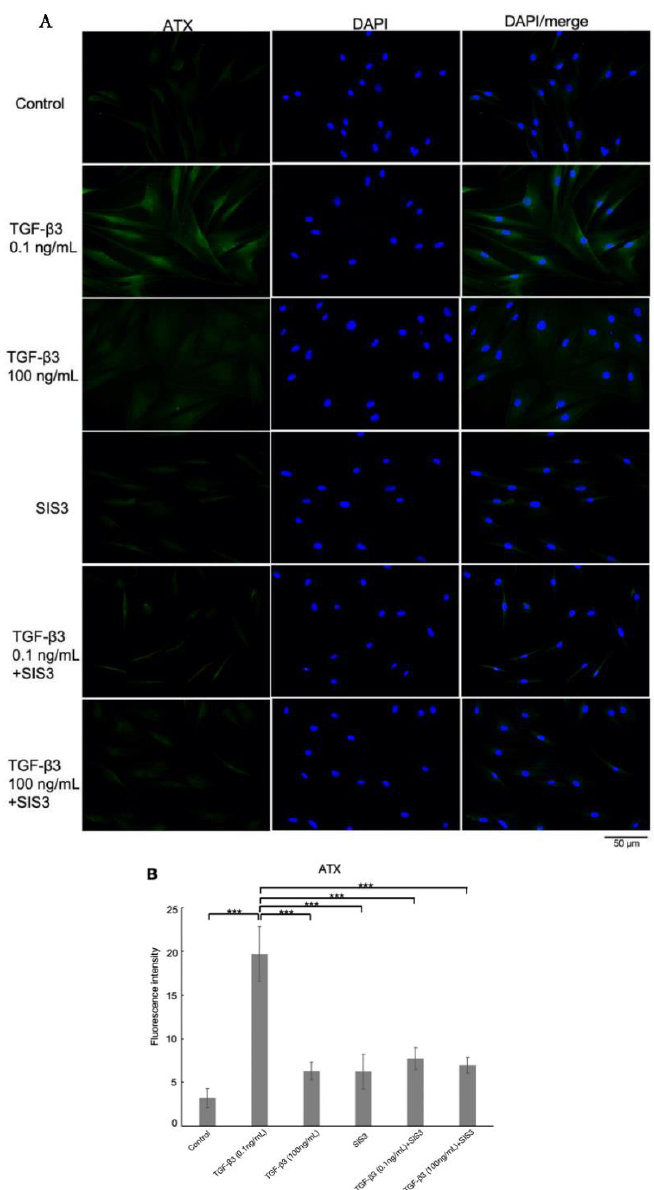
Figure 5. ( A ) Immunocytochemistry of ATX in HTM cells stimulated with TGF- β 3, with or without the Smad3 inhibitor, SIS3, and ( B ) the quantitative results based on immunocytochemistry. The left panels show cells stained for ATX (green). The middle panels show cells stained with 4′,6 -dia- midino-2-phenylindole (DAPI, blue). The right panels show merged images. The expression of ATX was increased with 0.1 ng/mL TGF- β3 treatment, and the change was attenuated by SIS3 treatment significantly. Data are presented as the mean ± standard deviation. *** p < 0.001. Bar, 50 μm, n = 4.